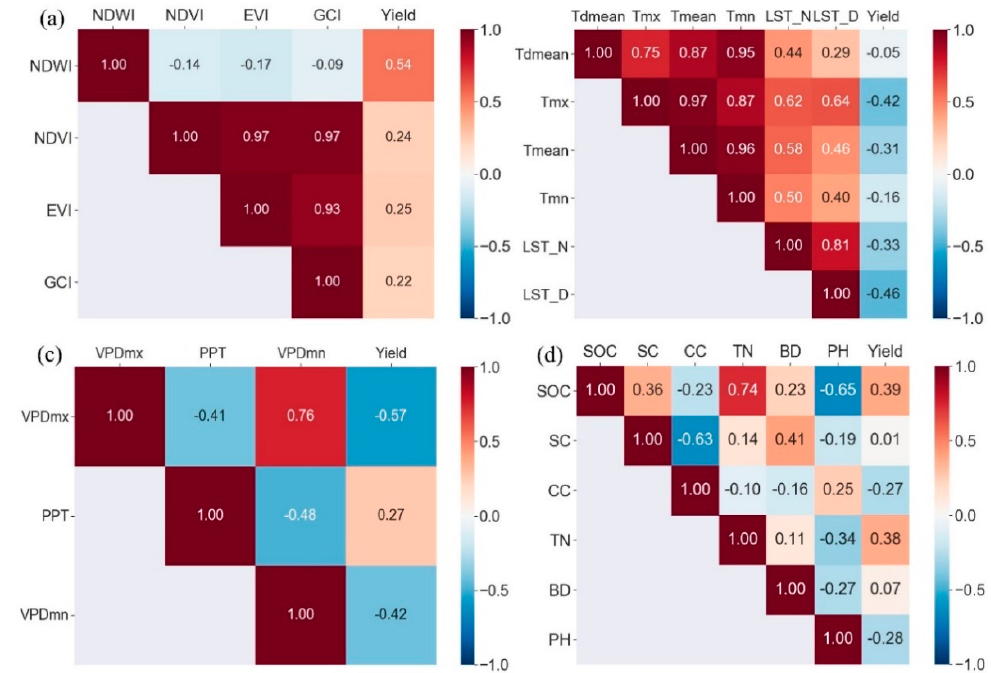
Figure 2. Correlation matrices for different data sources: ( a ) VIs; ( b ) Temperature-related factors; ( c ) Water-related factors; and, ( d ) Soil properties.